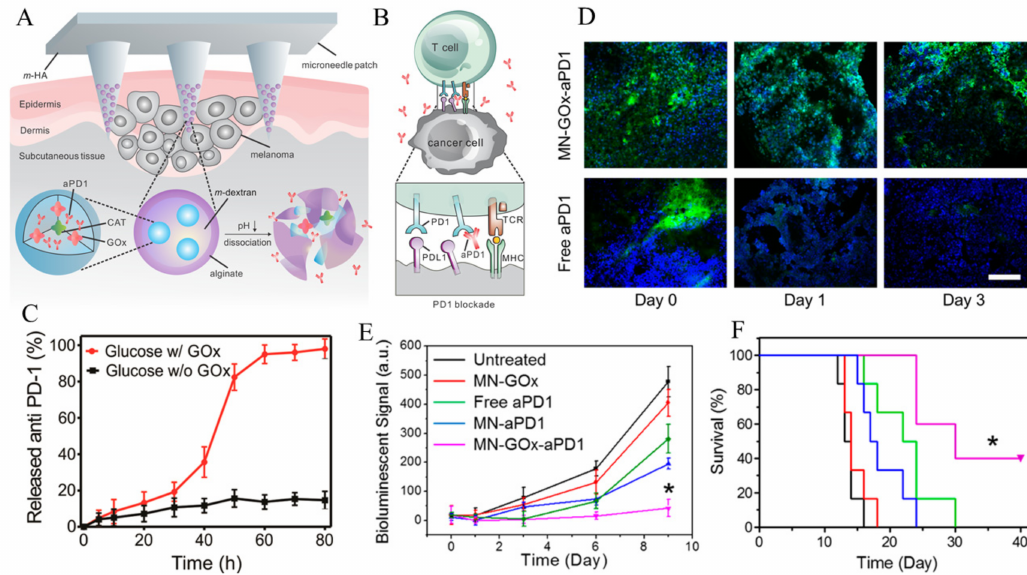
Figure 6. ( A ) Scheme of aPD1 delivery via microneedle (MN) patch, ( B ) Mechanism action of aPD1 to activate T-cell, ( C ) aPD1 release (%) from the MN patches in the presence of 100 mg / dL glucose solution at 37 ◦ C, ( D ) Immunofluorescence staining of tumors treated with MN-GOx-aPD1 or free aPD1 at di ff erent time points (green: aPD1, blue: nucleus), ( E ) Bioluminescence signals vs. time after treatment with di ff erent groups, and ( F ) % Survival plot of mice after MN patch-assisted delivery of aPD1 therapy. P value: *, p < 0.05. Reproduced with permission from [126]. Copyright 2016, American Chemical Society.